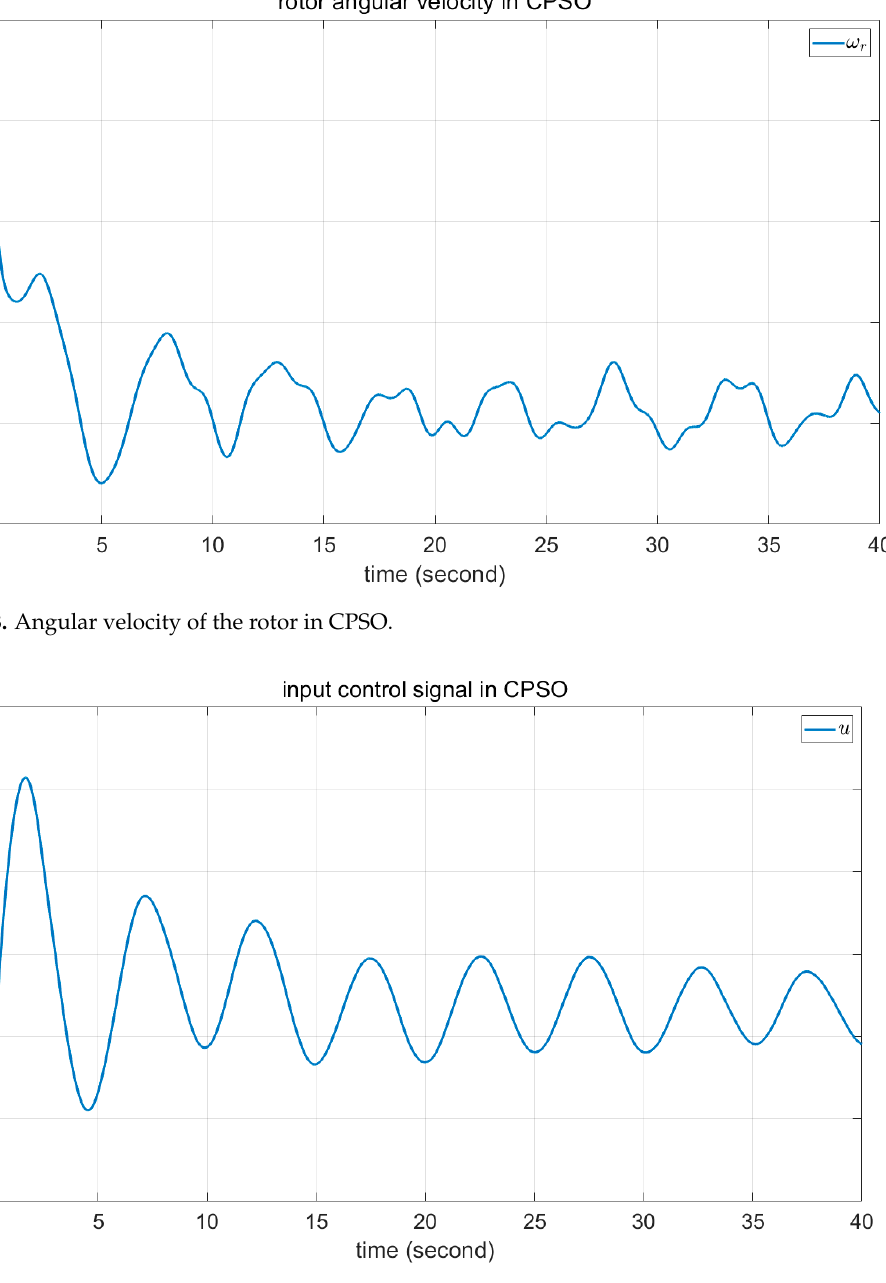
Figure 9. The input control signal of state feedback in CPSO.